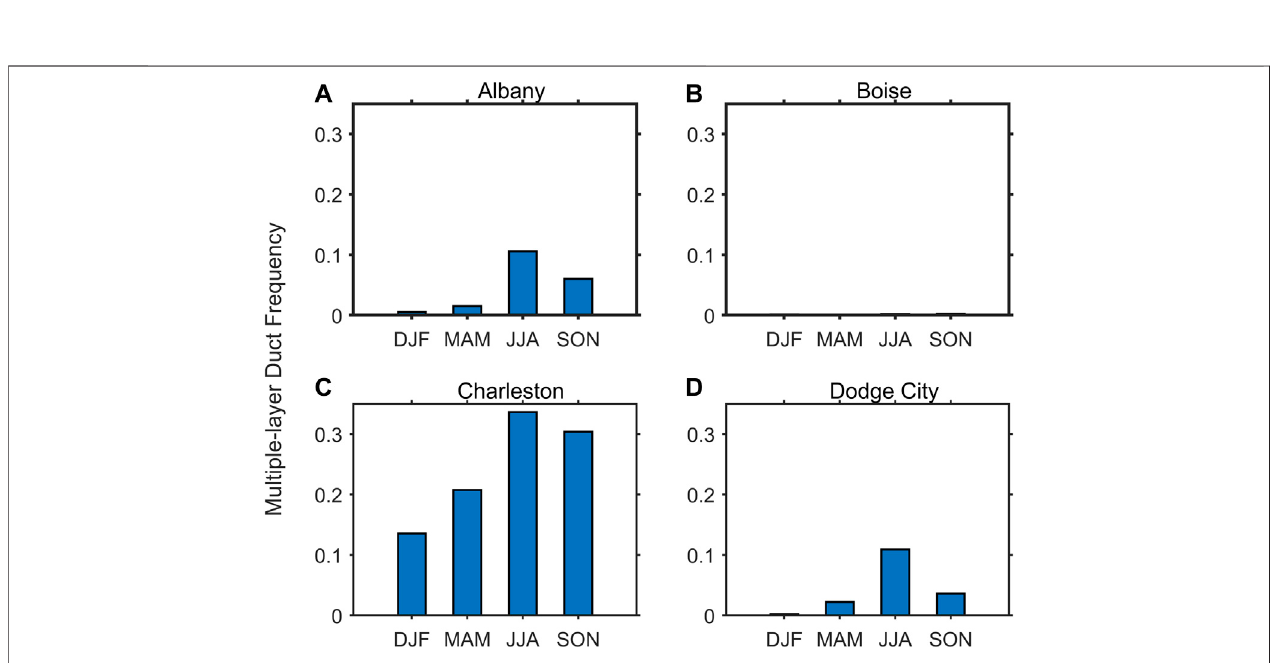
Frontiers in Environmental Science |